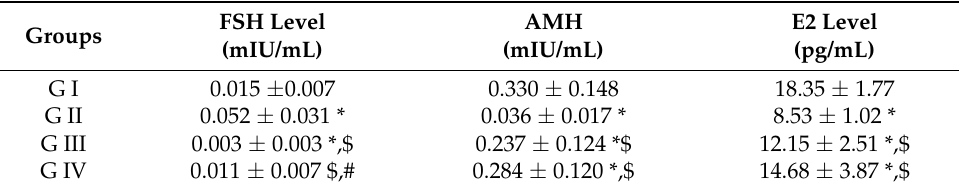
Table 2. Serum hormonal levels of Follicular stimulating hormone (FSH), Estradiol (E2), and Anti- mullerin hormone (AMH) in different groups.